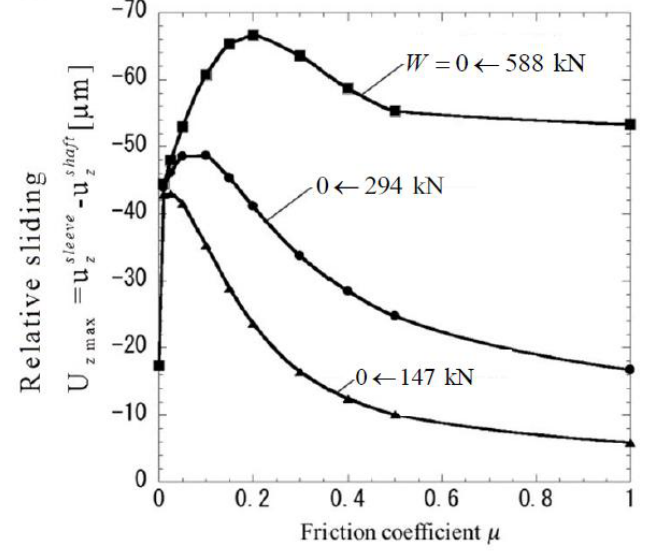
Figure 8. Effect of friction coefficient µ on maximum relative displacement after unloaded.